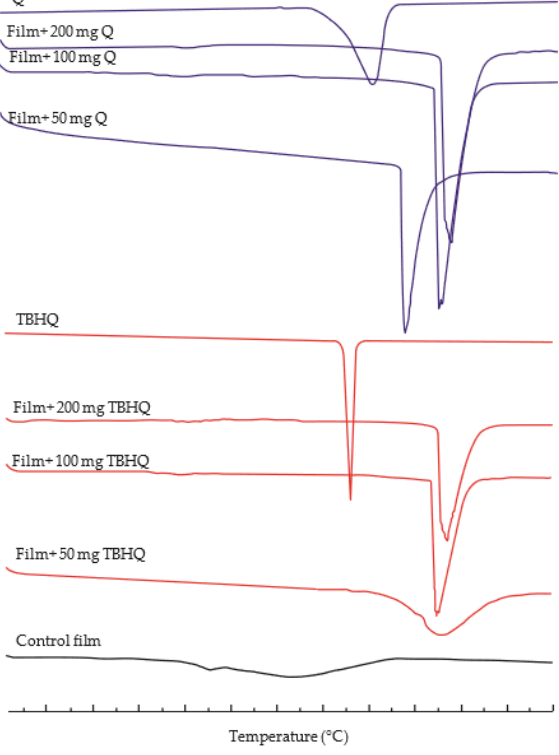
Figure 4. XRD peaks of cassava starch/gelatin films with quercetin (Q) and TBHQ (T).